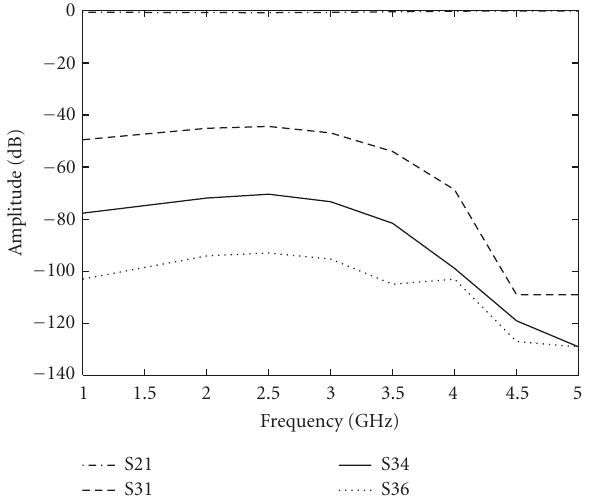
Figure 12: The theoretically predicted response of the ideal 2 × 2 coupler.